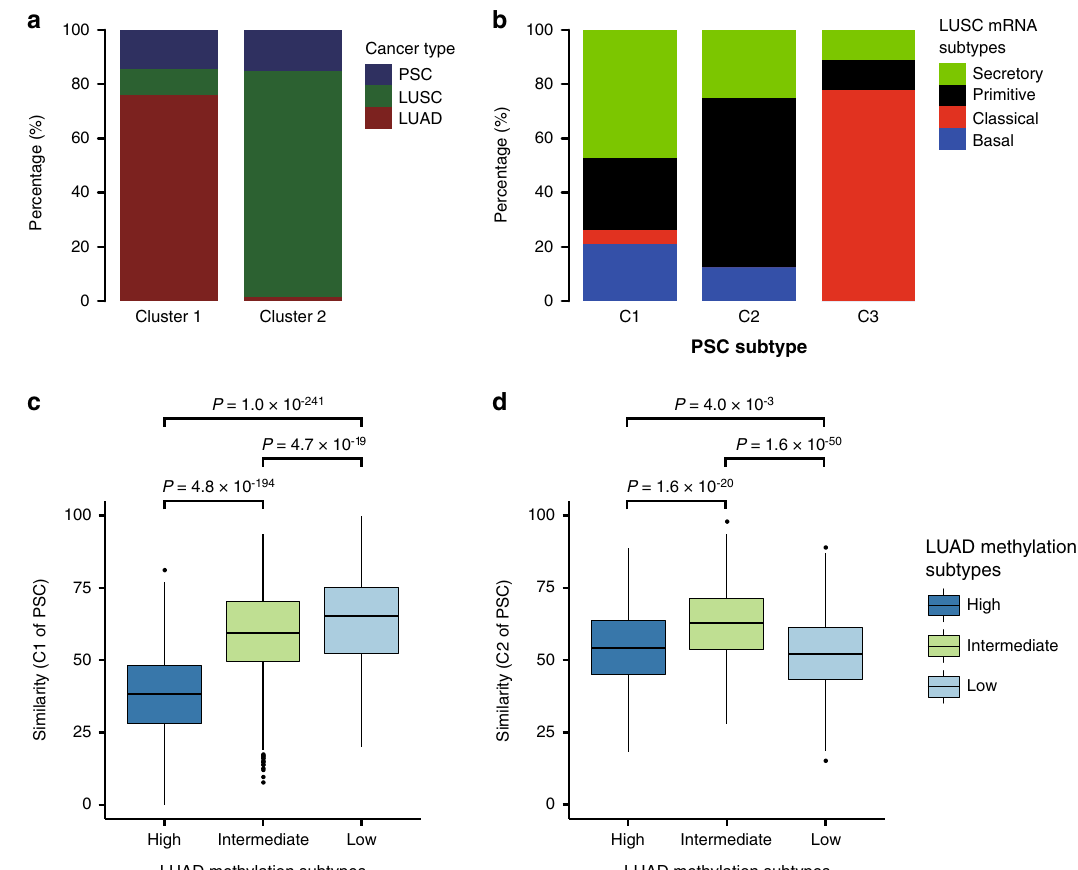
Fig. 6 Integrated analysis of PSC, LUSC and LUAD. a The percentage of PSC, LUSC, or LUAD in the two major clusters yielded by unsupervised hierarchical clustering of DNA methylation data. b The proportion of the four LUSC subtypes in three clusters of PSC. Source data are provided as a Source data fi le. c Boxplots show the Euclidean distance-based similarity between the DNA methylation pro fi les of C1 and three LUAD methylation subtypes. Source data are provided as a Source data fi le. d Boxplots show the Euclidean distance-based similarity between the DNA methylation pro fi les of C2 and three LUAD methylation subtypes. Center line, median; box limits, upper and lower quartiles; whiskers, 1.5× interquartile range; points, outliers. Two-sided Wilcoxon rank-sum test was used for statistical analysis of ( c ) and ( d ). No P -value adjustment was applied. Source data are provided as a Source data fi